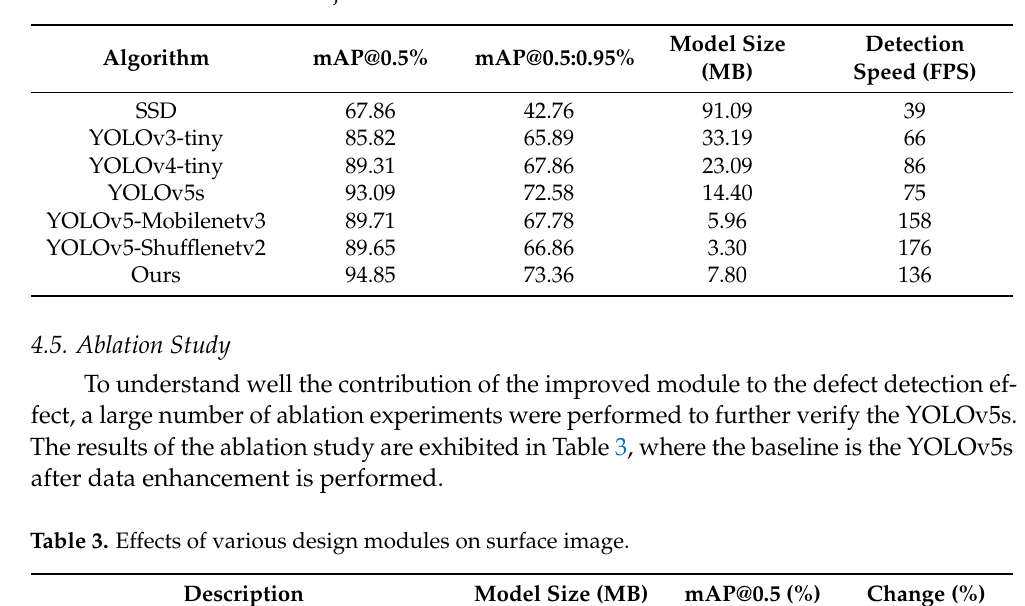
Figure 7. Visual inspection results for four types of defects. Table 2. Results of different object detection models.